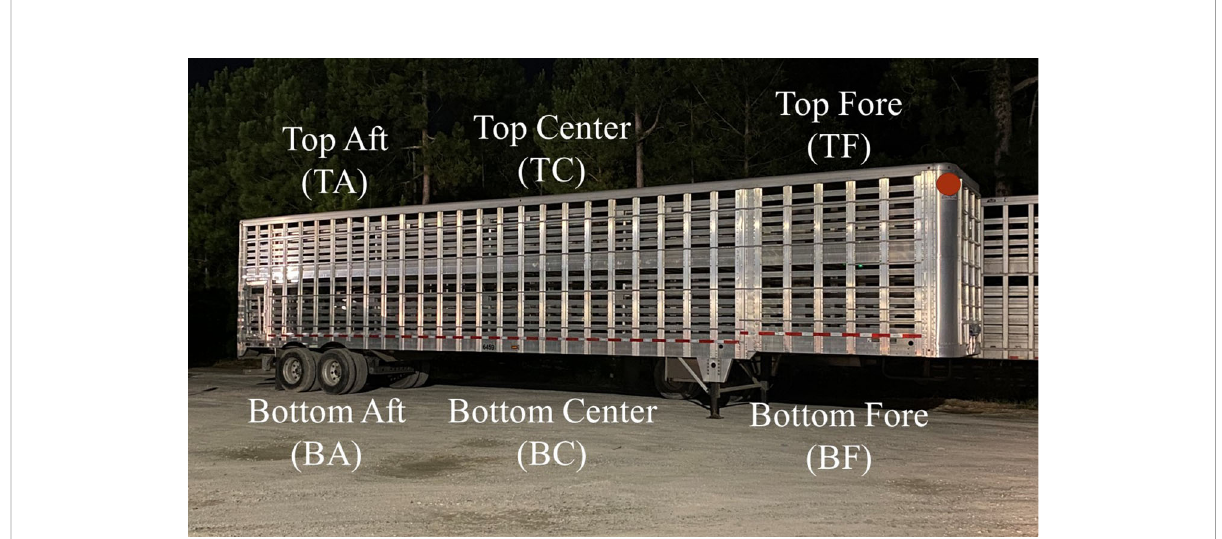
FIGURE 1 Pictoral representation of straight-deck trailers and approximate sensor placement locations with abbreviation in parentheses. Six locations were top aft (rear; TA), top center (TC), top fore (front; TF), bottom aft (rear; BA), bottom center (BC), and bottom fore (front;